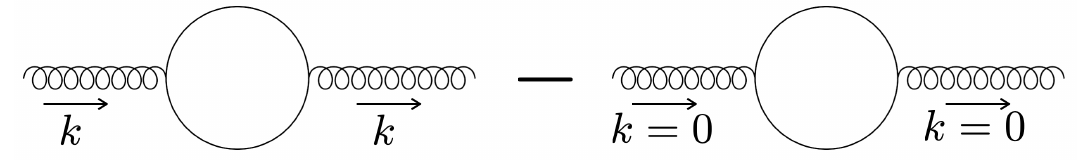
Figure 5 . Zero momentum subtraction of the sub-diagram (meaning the gluon self-energy diagram) implemented to calculated the wave function due to loop diagram in figure